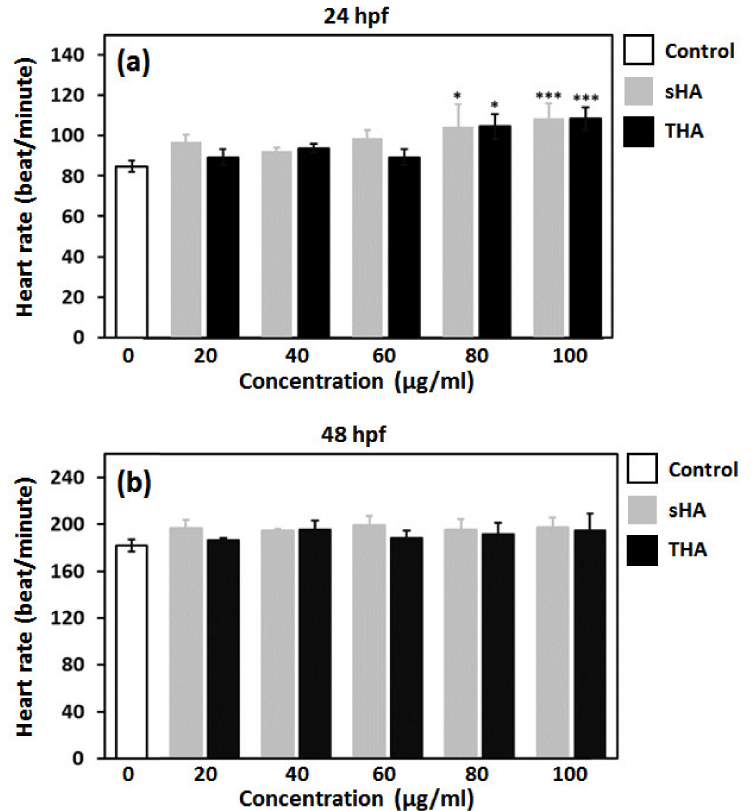
Figure 13. Effect of sHA and THA powders at varying concentrations on the heart rates of zebrafish embryos at 24 hpf ( a ) and 48 hpf ( b ). The results are presented as mean ± SE (n = 3), * p < 0.05, *** p < 0.001 versus